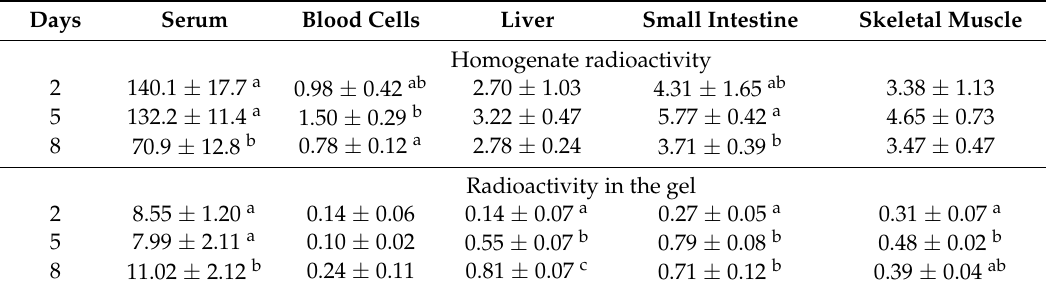
Table 2. Radioactivity (disintegrations per min/ µ g of protein) associated with serum and selected tissues of mice provided a supplement of MSM labeled with 35 S for 2, 5 and 8 days. Values are means and SEM for total radioactivity measured in the homogenates and proteins associated with the gels after electrophoresis. Values with different letter superscripts in the same column for the homogenates and gels are significantly different ( p <